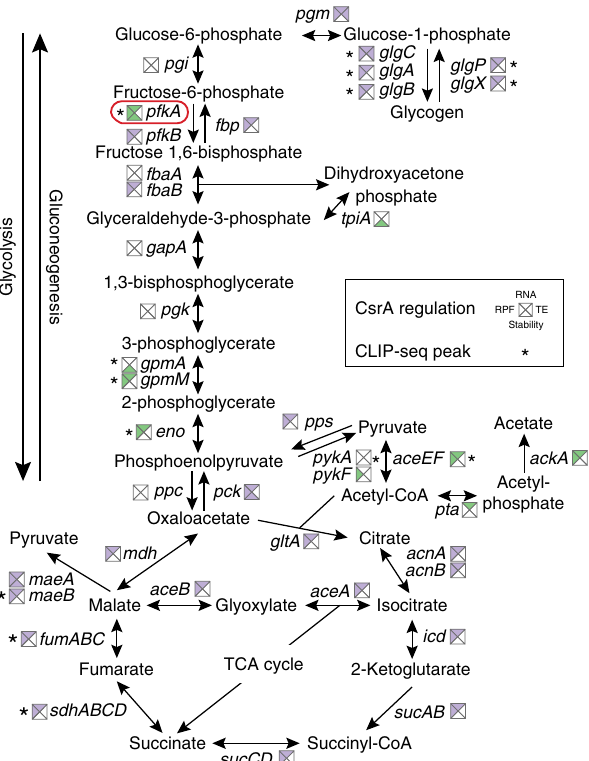
Fig. 4 CsrA activates glycolysis and represses gluconeogenesis and the tricarboxylic acid cycle. Effects of CsrA on gene expression in central carbon metabolism. Squares near gene names show effect of CsrA on translation (RPF, left), RNA abundance (RNA, top), RNA stability (stability, bottom), and/or translation ef fi ciency (TE, right). Purple indicates repression by CsrA and green indicates activation. Asterisks indicate that a CsrA CLIP-seq peak is associated with the gene. A red box highlights the key role of pfkA on CsrA-dependent effects on